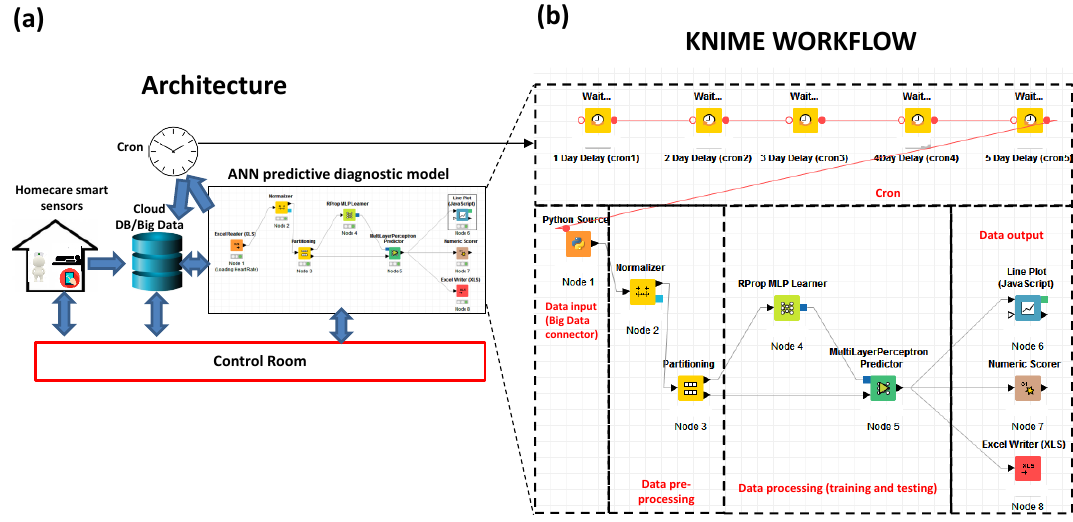
Figure 1. ( a ) Architecture of homecare smart assistance platform based on artificial neural networks (ANN) data processing [19]; ( b ) Konstanz Information Miner (KNIME) workflow implementing a traditional ANN multi-layer perceptron (MLP) [19].